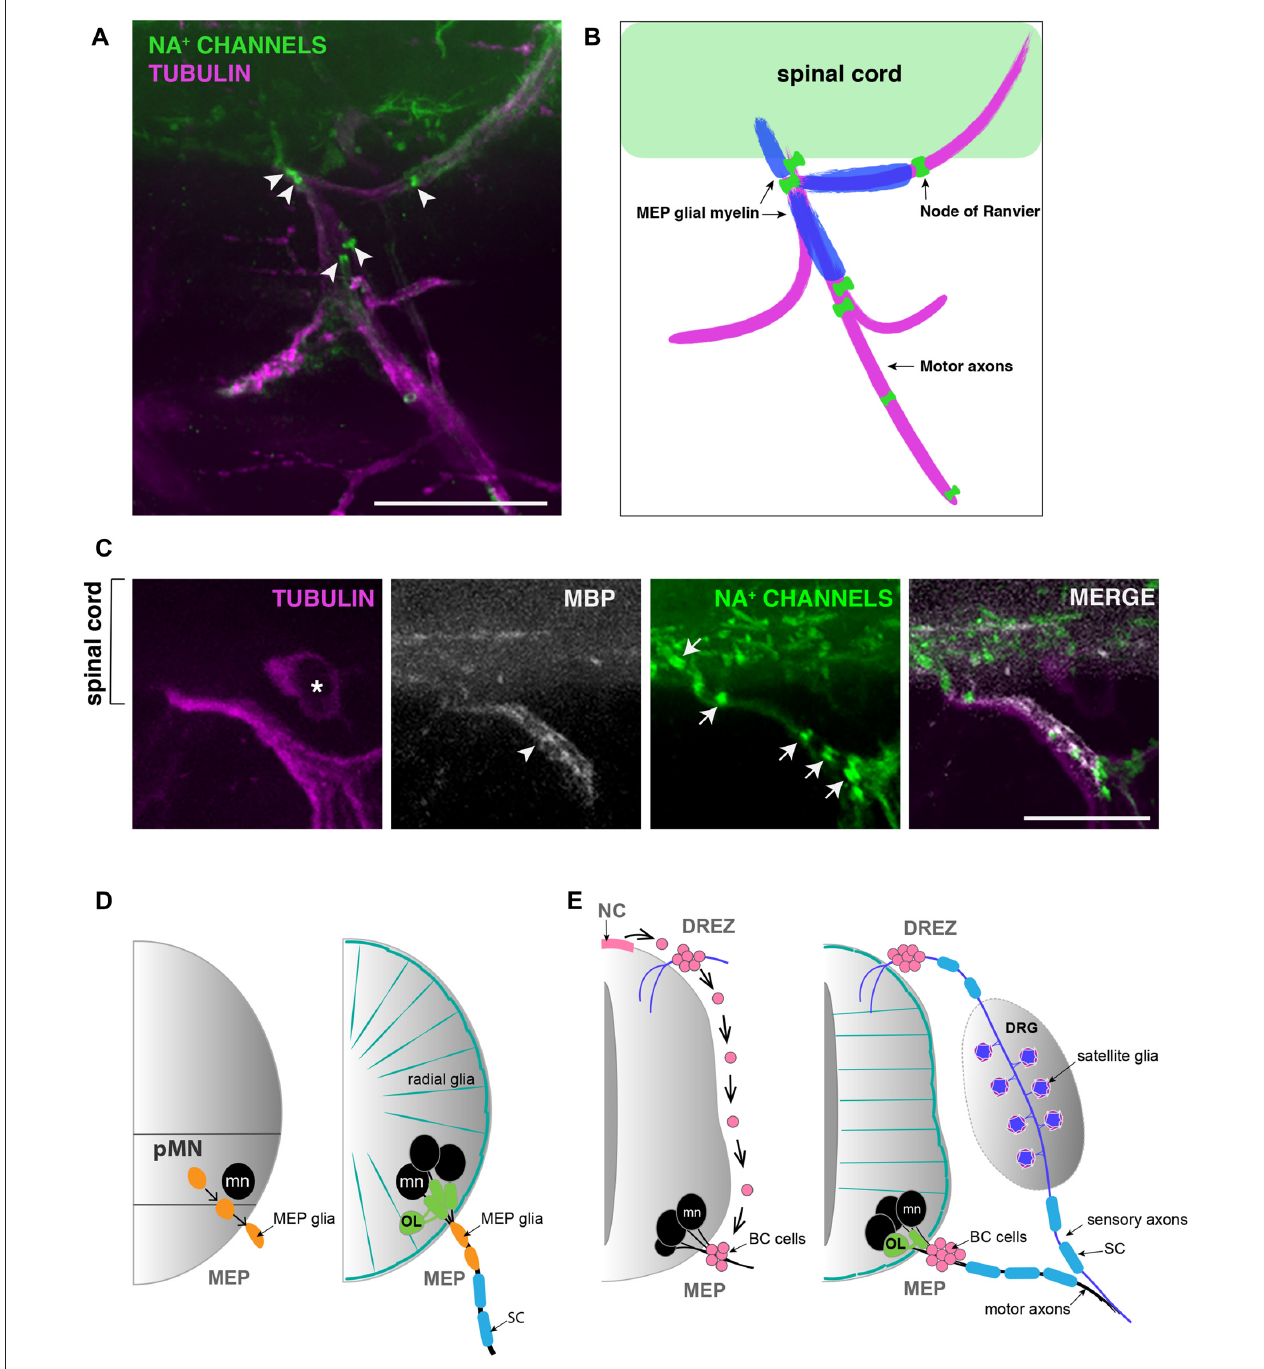
FIGURE 2 | MEP glial myelin is flanked by nodes of ranvier. (A) Lateral view of a 5 dpf zebrafish trunk stained with antibodies specific to pan Na + channels (clone k58/35) and acetylated tubulin shows that MEP glial territory is flanked by sodium channels clustered in Nodes of Ranvier (arrowheads) along motor nerve roots. (B) Diagram showing MBP + MEP glial myelin (blue) delineated by nodes of Ranvier (green) along motor nerve root axons (magenta). (C) Immunostaining showing MBP + MEP glial myelin (arrowhead) and nodes of Ranvier (arrows) along motor nerve root axons (magenta). Asterisks point to dorsal root ganglion (DRG). (D) Schematic of zebrafish MEP transition zones (TZs) and the diverse populations of glial cells orchestrating the CNS/PNS boundary. CNS-derived MEP glia (orange) that reside along motor neuron (mn; black) axons restrict the oligodendrocyte lineage (OL; green) to the spinal cord. Radial glia (teal green) cover the surface of the spinal cord and prevent peripheral glia such as MEP glia and SC (blue) from entering the CNS. (E) Schematic of a mammalian neural tube showing neural crest (NC)-derived boundary cap (BC) cells (pink) sitting at the dorsal root entry zone (DREZ) and MEP TZs. BC cells prevent mn (black) cell bodies from transgressing the spinal cord boundary. Scale bar, (A) 50 µ m, (C) 25 µ m.